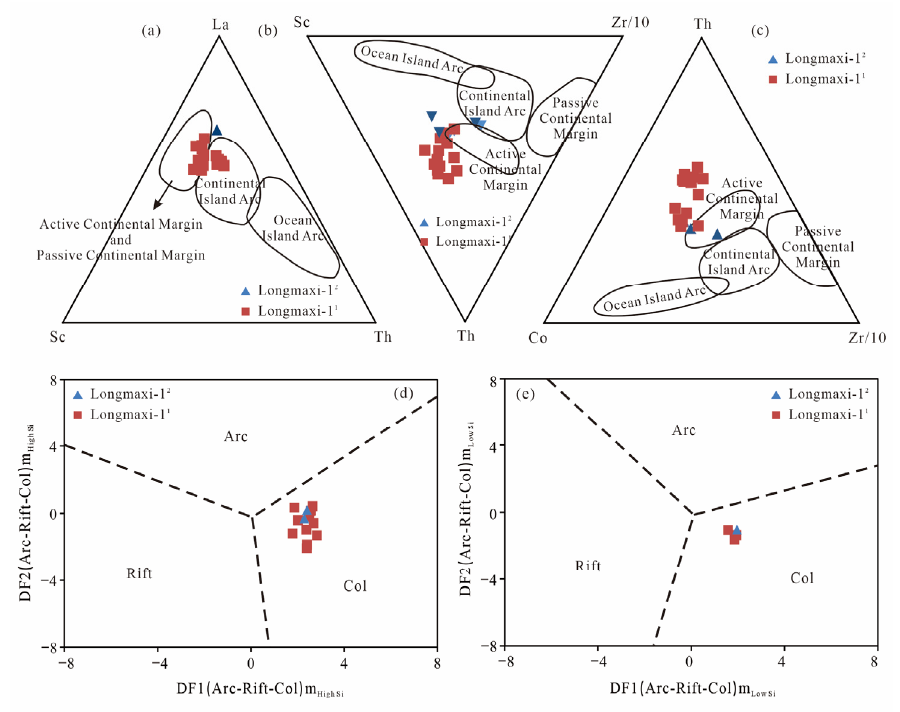
Figure 8. Tectonic setting discrimination diagram in Longmaxi-1 black shales. ( a – c ) La-Sc-Th, Th- Zr/10-Sc, Th-Co-Zr/10 [87]; ( d , e ) DF1-DF2 discrimination function diagrams [89]. Notes: Arc—land arc; Rift—continental rift; Col—subduction collision orogeny.